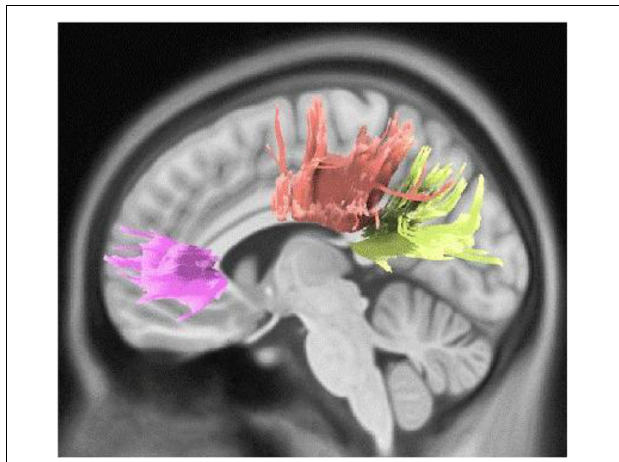
FIGURE 4 | White matter pathways with significantly negative association with musical training in female participants (FDR =